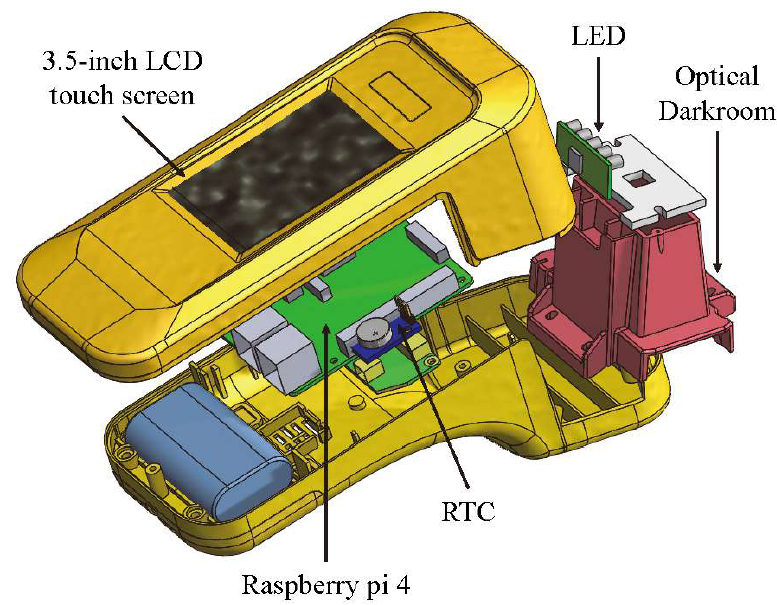
Figure 4. Exploded view of the rapid test system.